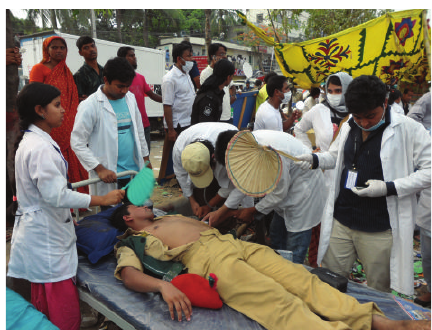
Figure 5: Treatment at make-shift camp after Rana Plaza